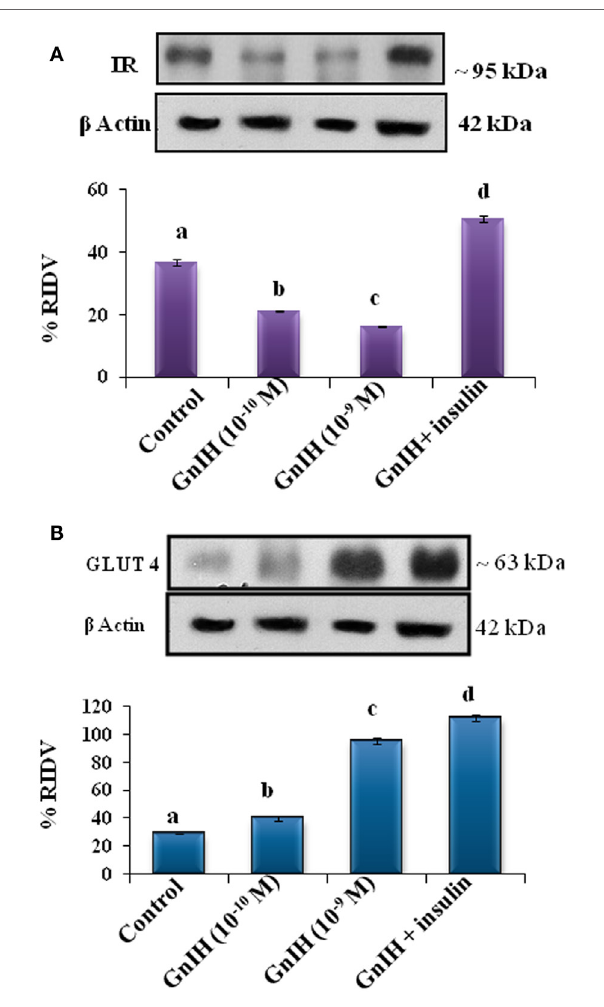
FigUre 7 | The in vitro treatment of adipose tissue with different doses (10 − 10 M and 10 − 9 M/ml) of gnih with or without insulin (10 μ g/ml) showed (a) a dose-dependent (b and c, p < 0.05) significant decrease in expression of ir protein as compared with the control with (10 − 10 M and 10 − 9 M/ml) of gnih . The treatment with a high dose of GnIH together with insulin showed a significant (d, p < 0.05) increase in the expression of IR protein in as compared with the only GnIH-treated group. (B) The in vitro treatment of adipose tissue with different doses (10 − 10 and 10 − 9 M/ml) of GnIH with or without insulin (10 μ g/ml) showed a dose-dependent significant ( p < 0.05) increase in the expression of GLUT 4 protein as compared with the control. The treatment with the high dose of GnIH together with insulin showed a significant (d, p < 0.05) increase in the expression of GLUT4 protein in the adipose tissue as compared with only GnIH-treated group.